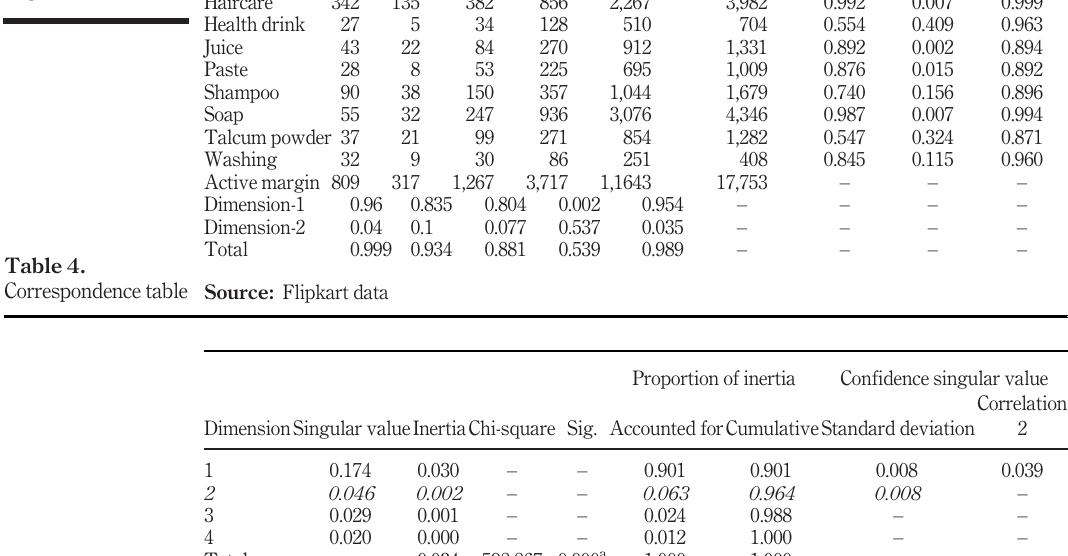
Table 5. Fitness measures